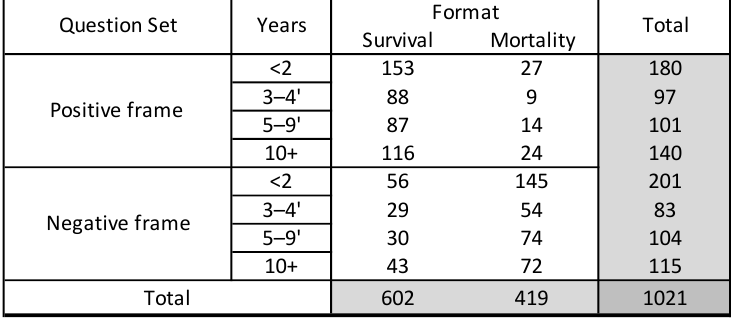
Figure 11. Respondent totals by years in home.